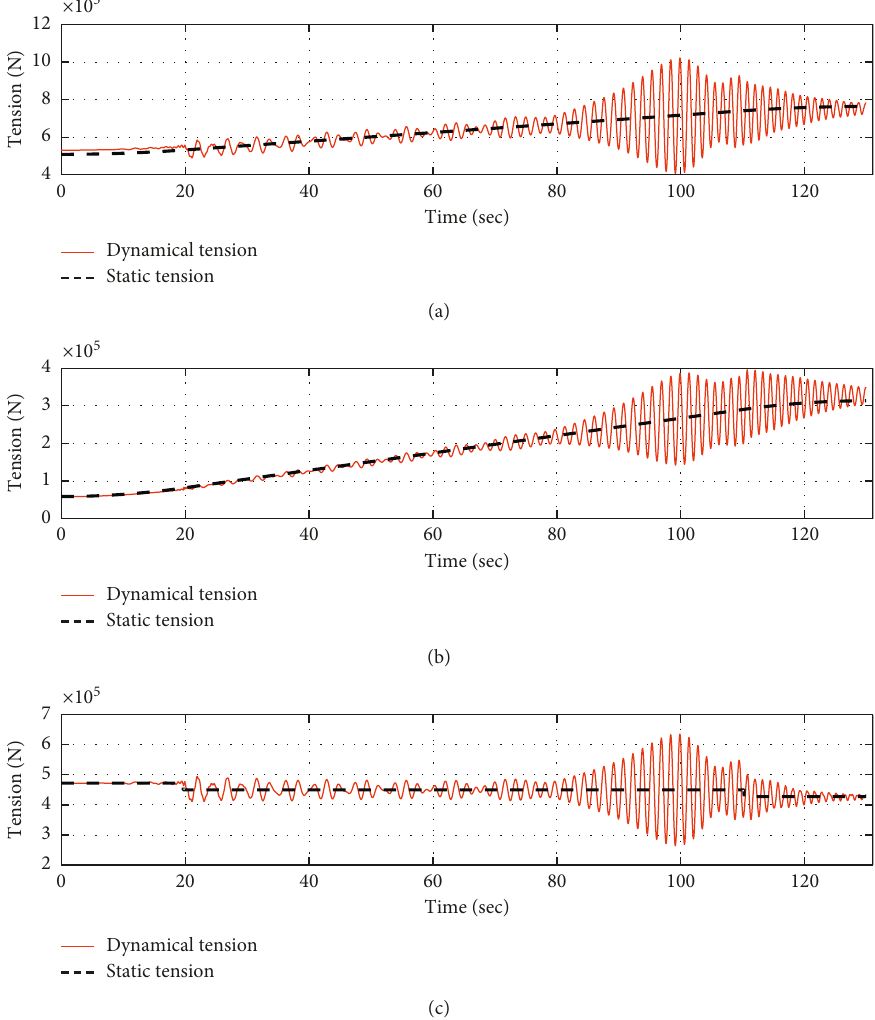
Figure 9: Longitudinal tension of the traction system at (a) connecting point A (shown in Figure 1), (b) connecting point B (shown in Figure 1), and the (c)